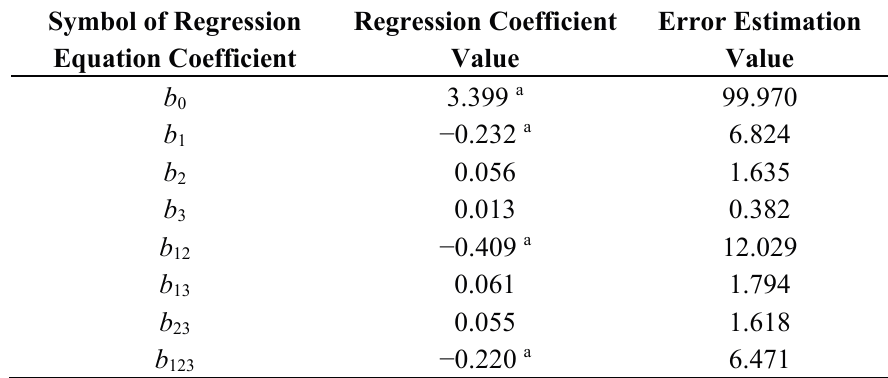
Table 5. Coefficients of the regression equation of the full factorial experiment, statistically significant coefficients ( a ) error estimation value for s bj = 0.034 and regression equation coefficients statistically significant ( a